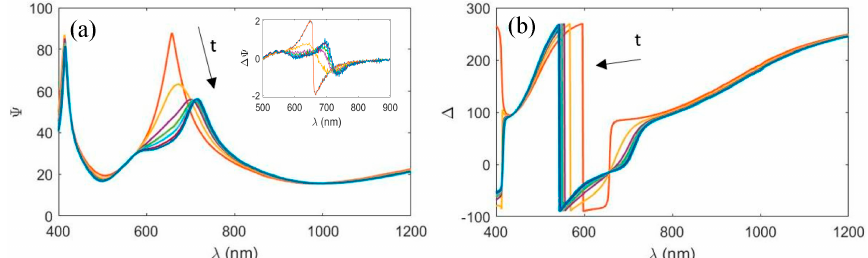
Figure 6. Plots of Ψ and ∆ (( a , b ), respectively) measured at different UV exposure times for a T-T polyurethane sample. The inset in ( a ) reports the difference spectra δ Ψ = Ψ (t) − Ψ (0) in the spectral region to emphasize the polymer color